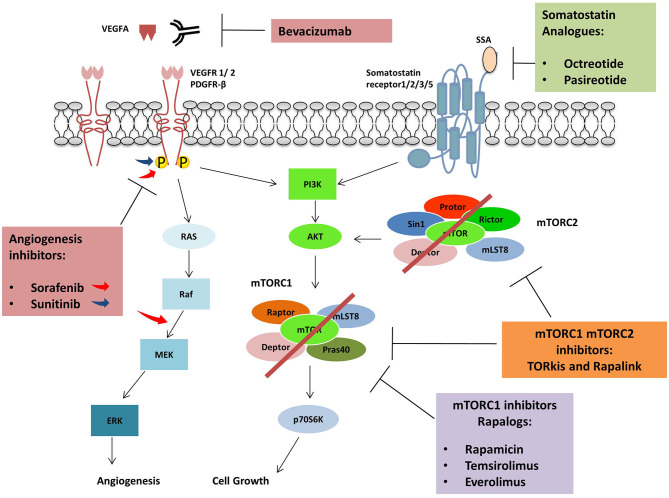
Agents used in combination with mTORC1 inhibitors: Protein kinase inhibitors, Sorafenib and Sunitinib are active against several tyrosine kinases receptors (RTKs) including VEGFR and PDGFR. Sorafenib can also inhibit RAF kinases. The monoclonal antibody Bevacizumab inhibits angiogenic pathway binding VEGFA and avoiding VEGFRs activation. Somatostatin analogs bind somatostatin receptors impairing cell growth while Rapalogues can inhibit mTORC1.